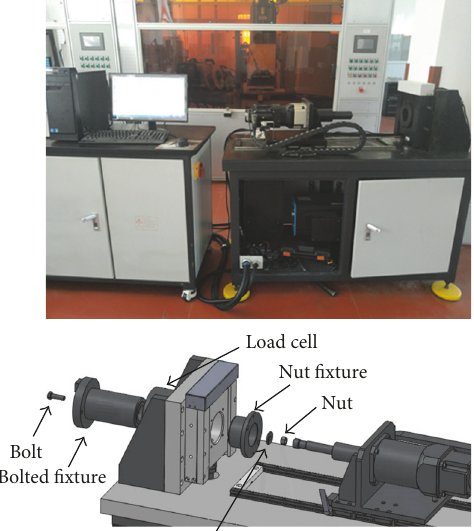
Figure 10: The test rig.